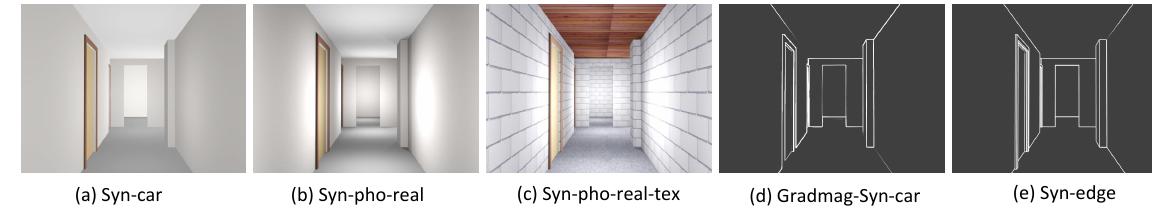
Figure 3. Different types of synthetic images generated from the 3D model.